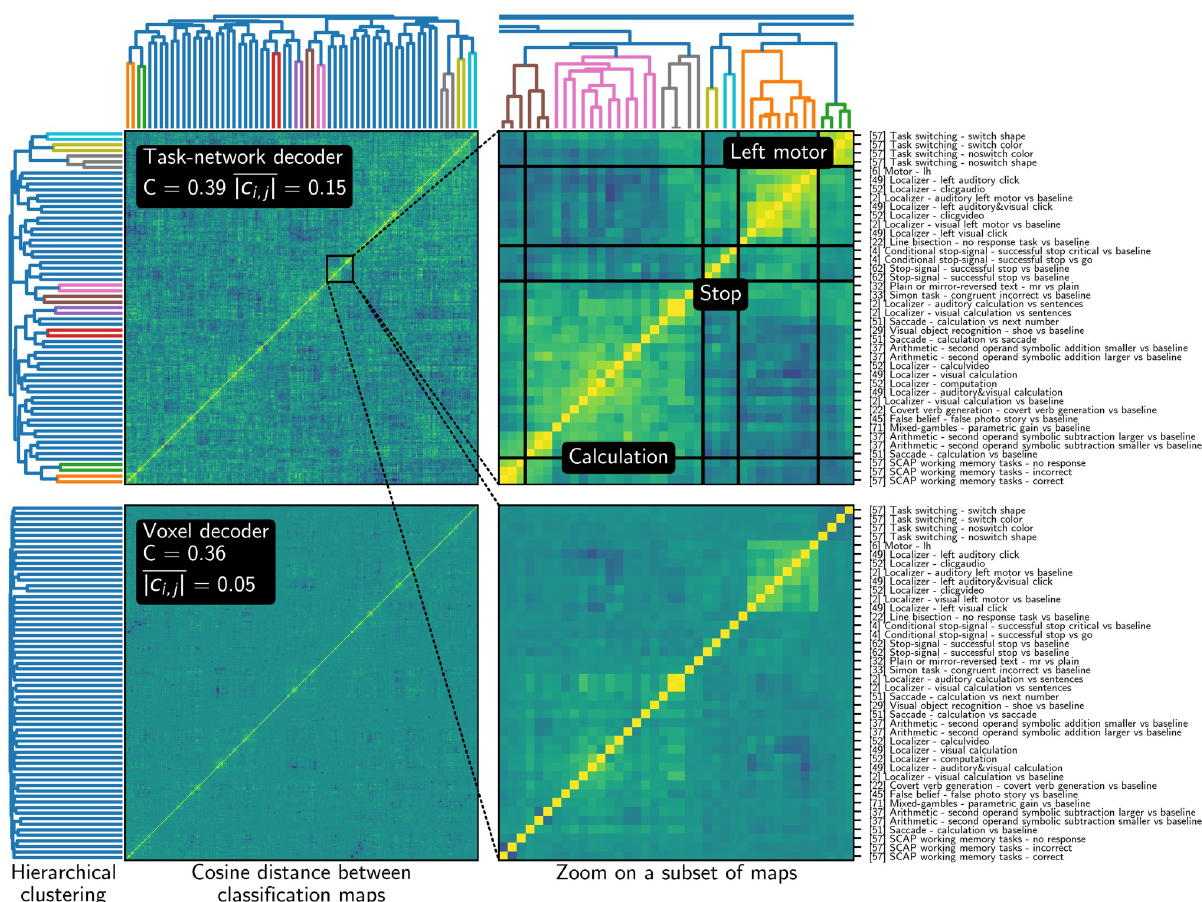
Fig 7. Cosine similarities between classification maps, obtained with our multi-study decoder (top) and with decoders learned separately (bottom), clustered using average-linkage hierarchical clustering. The classification maps obtained when decoding from task-optimized networks are more easily clustered into cognitive-meaningful groups using hierarchical clustering—the cophenetic coefficient of the top clustering is thus higher. Maps may also be compared using the similarities of their loadings on MSTONs, with similar